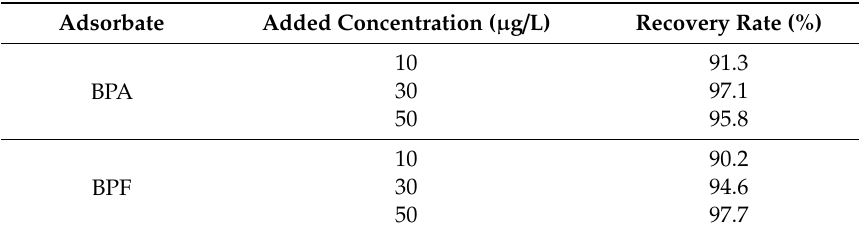
Table 3. Results of the adsorption of BPA and BPF in real wastewater samples under the optimum conditions ( n =